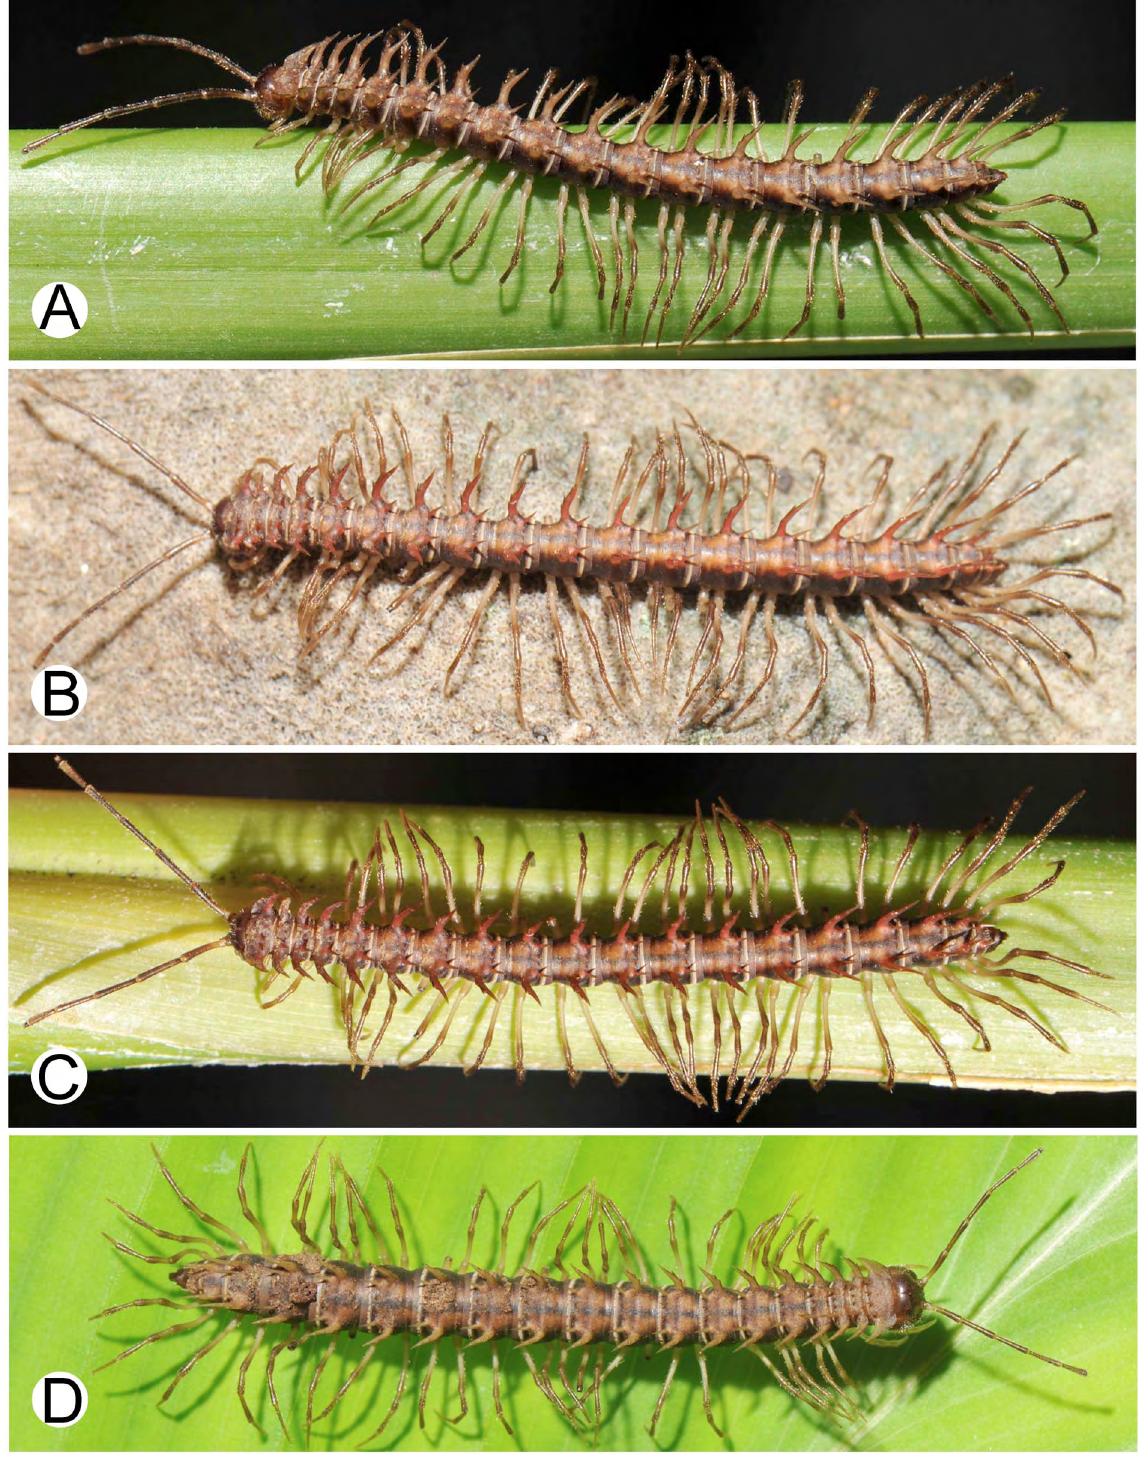
Fig. 11. Live photographs of Nagaxytes erecta Srisonchai, Enghoff & Panha gen. et sp. nov. A – B . Specimens from Phuphrai Thannam Resort, Thailand (♂♂, CUMZ-pxDGT00002-3). C . Specimen from Ban Nong Bang, Thailand (♂). D . Specimen from Phuphrai Thannam Resort, Thailand (♀, CUMZ-